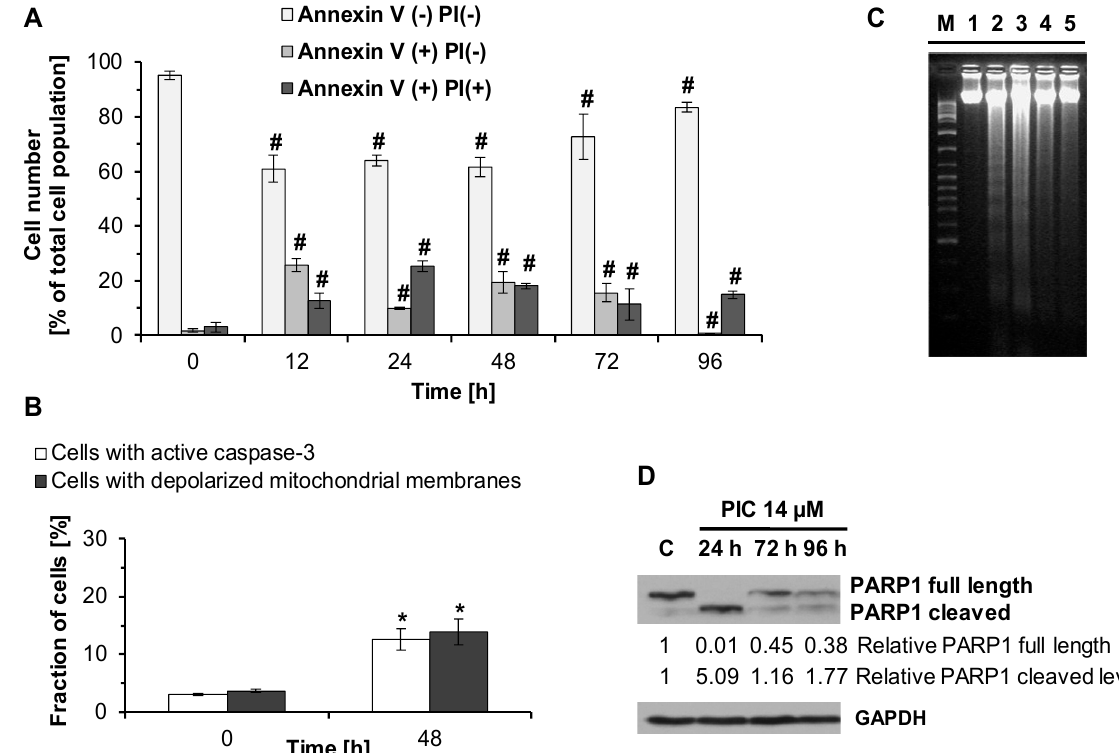
Figure 6. Detection of apoptosis in piceatannol-treated HL-60 cells. ( A ) Effect of piceatannol on phosphatidylserine externalization and loss of plasma membrane integrity in HL-60 cells. Cells were treated with piceatannol (IC 90 = 14 µ M) for 12, 24, 48, 72, and 96 h. Data are presented as means ± SD of three independent experiments. # p < 0.0001, statistically significant differences compared to control (One-way ANOVA, Dunnett’s post hoc analysis). ( B ) Effect of piceatannol on caspase-3 activation and changes of the mitochondrial membrane potential in HL-60 cells. Cells were treated with piceatannol (IC 90 = 14 µM) for 48 h. Data are presented as means ± SD of three independent experiments. * p < 0.05, statistically significant differences compared to control—untreated cells (Mann–Whitney U test). ( C ) Effect of piceatannol on DNA fragmentation in HL-60 cells. Cells were exposed to piceatannol (IC 90 = 14 µM) for 12, 24, 48, and 72 h. M, 100–10,000 bp DNA marker; lane 1, control (untreated cells); lanes 2–5, 12, 24, 48, and 72 h of piceatannol treatment, respectively. Data are representative of three independent experiments. ( D ) Effect of piceatannol on PARP1 cleavage in HL-60 cells. Cells were exposed to piceatannol (PIC, IC 90 = 14 µM) for 24, 72, and 96 h. C–control (untreated cells). The relative levels of full-length PARP1 (113 kDa) and cleaved PARP1 (89 kDa) normalized to loading control GAPDH were quantitated by densitometry. Similar results were obtained in three independent experiments.